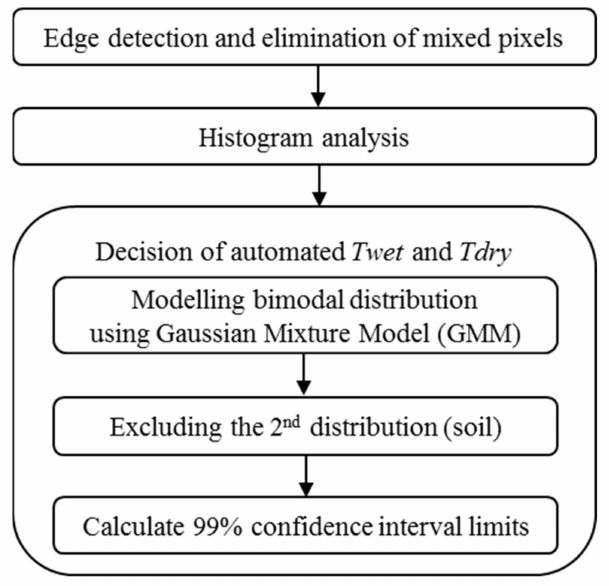
Figure 2. Flowchart of the analysis steps for CWSI estimation based on adaptive reference